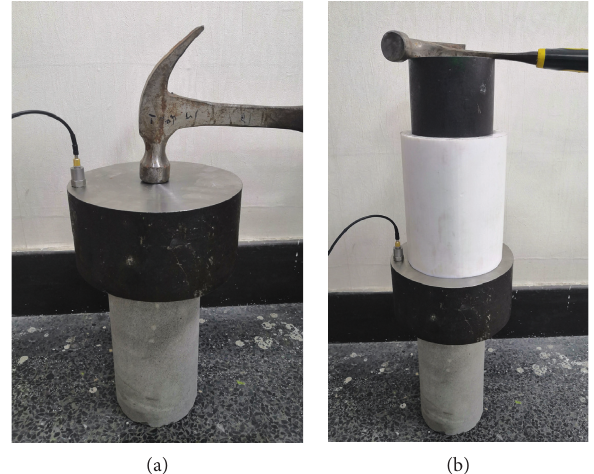
Figure 1: Impact source: (a) without Teflon; (b) with Teflon.